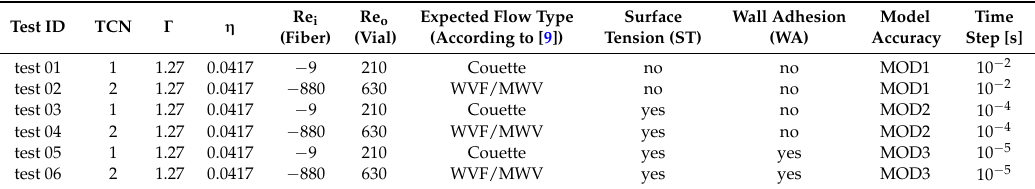
Table 1. Simulation matrix for model assessment.